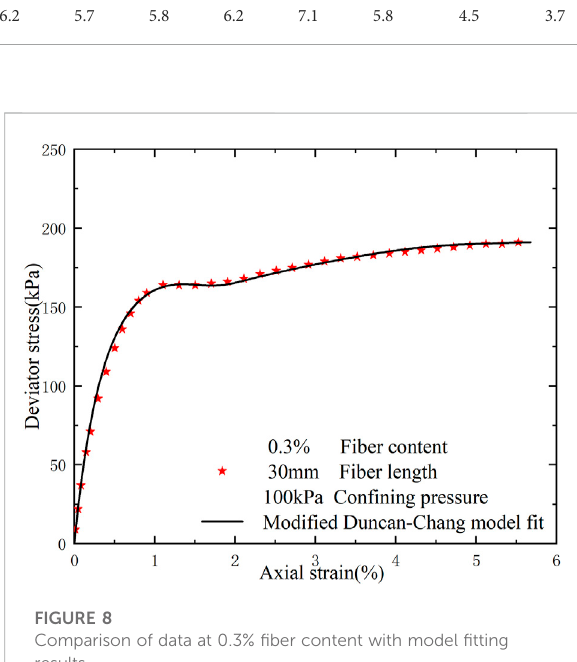
FIGURE 8 Comparison of data at 0.3% fi ber content with model fi tting